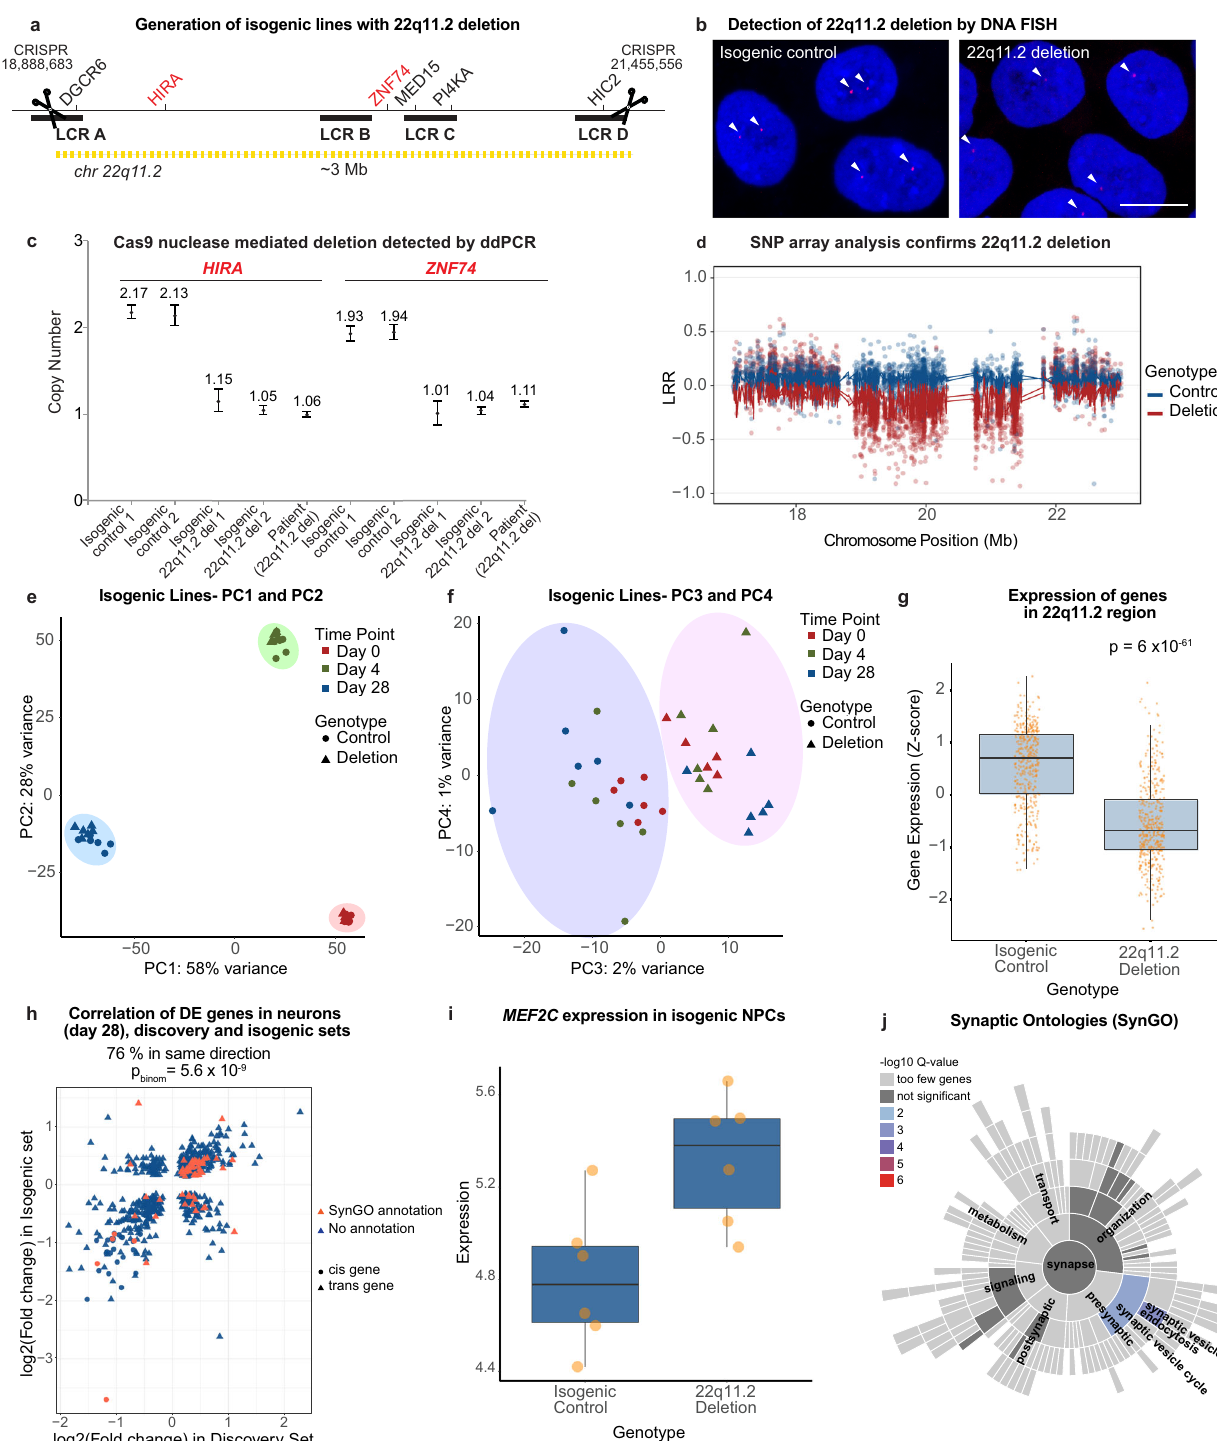
were on average 0.29 standard deviations (SDs) higher expressed in the edited lines (95%-CI:0.17 – 0.41 SDs, p = 1.8 × 10 − 6 , t -test), with18 of these being individually signi fi cantly ( p value < 0.05) after gene editing ( p = 0.03 binomial test) (Supplementary Data 19).